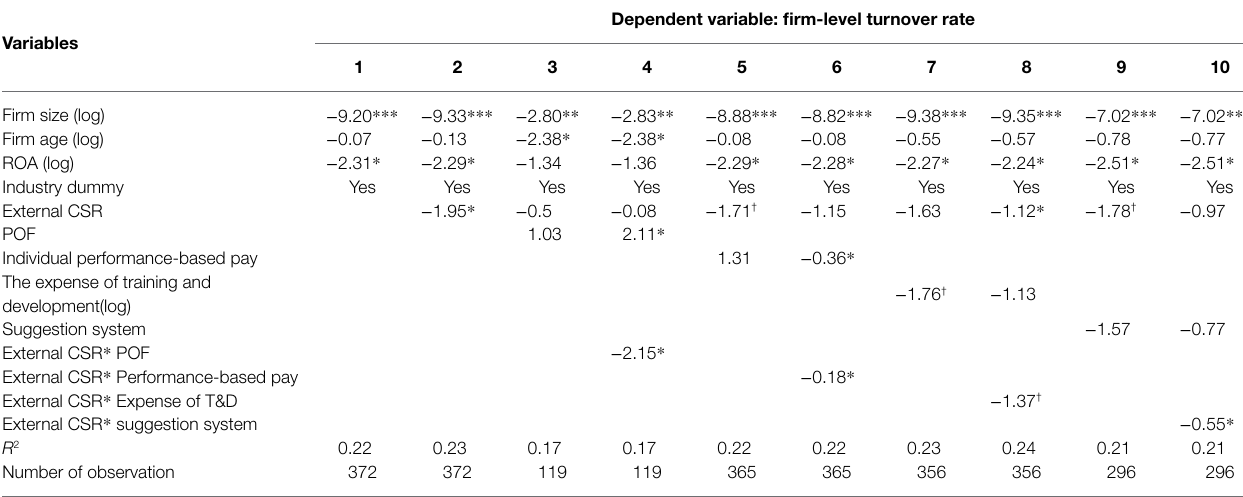
TABLE 2 | Results of regression analysis of the CSR, HR practices, and Turnover rate.